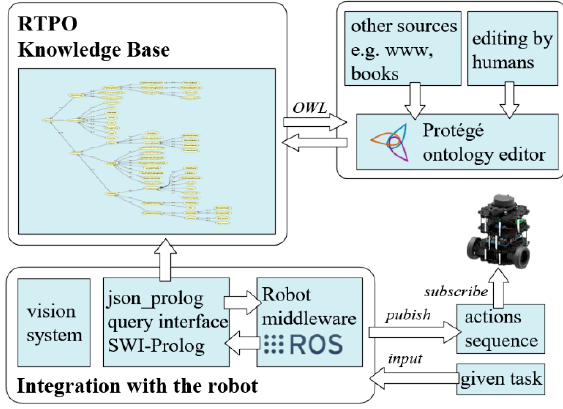
Figure 2. The implementation process of RTPO building.